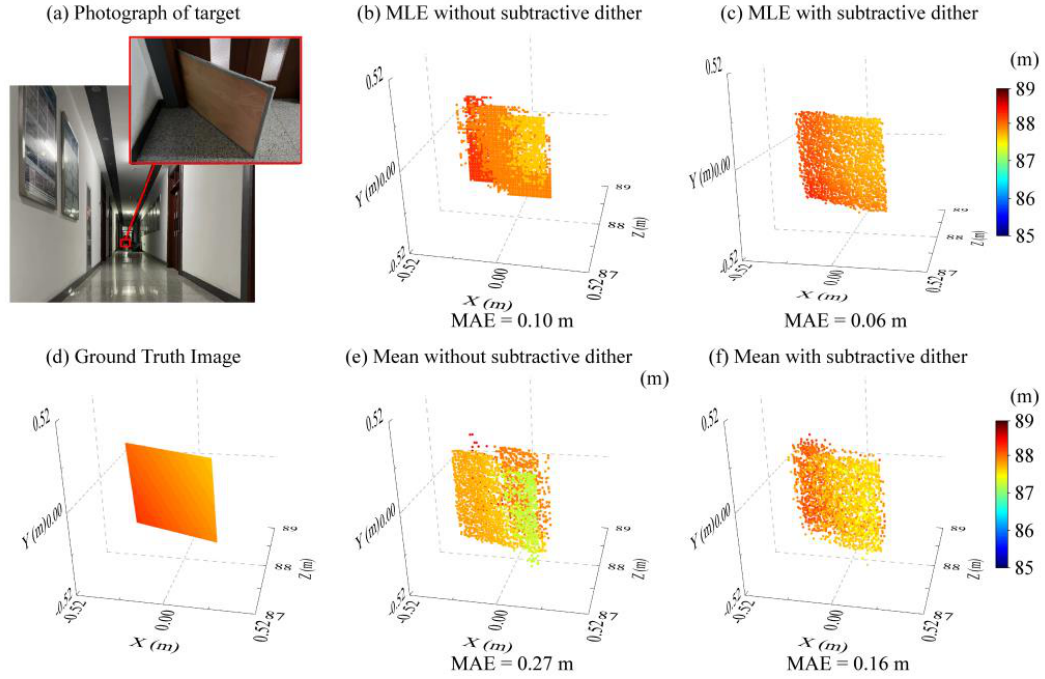
Figure 4. The 3D imaging result of SPL acquired by illuminating an inclined planar target at a distance of approximately 88 m. ( a ) The photograph of the target scene. ( b ) The reconstructed 3D image using MLE without subtractive dither. ( c ) The reconstructed 3D image using MLE with subtractive dither. ( d ) The ground truth image modeled by four vertices. ( e ) The reconstructed 3D image using the mean without subtractive dither. ( f ) The reconstructed 3D image using the mean with subtractive dither.